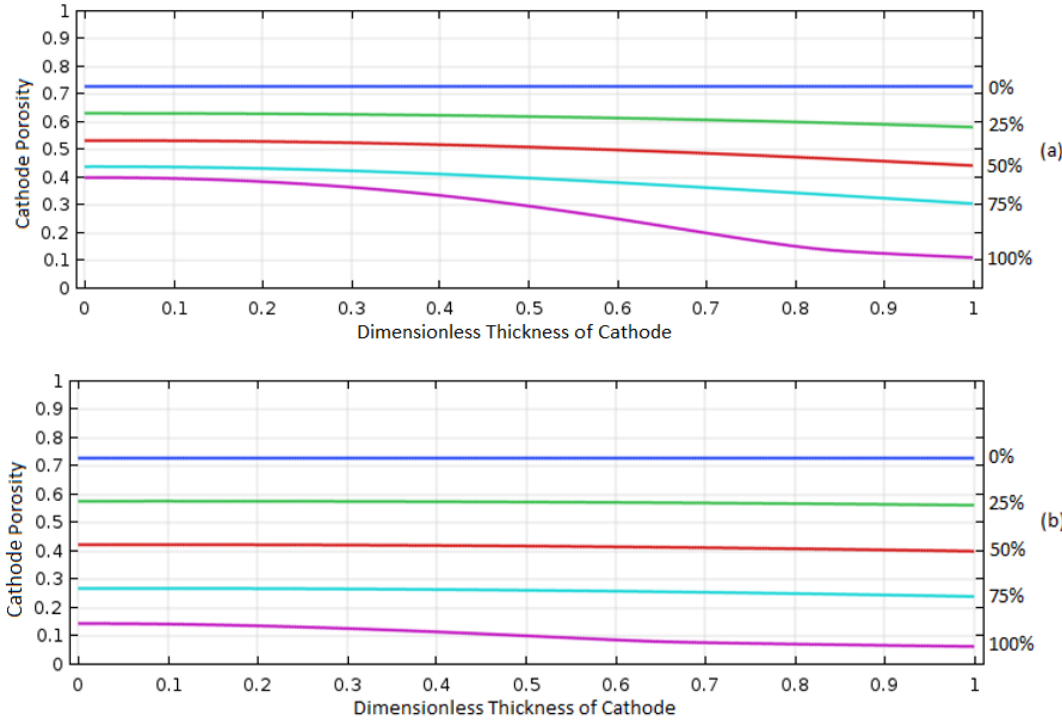
Figure 8. Distribution of cathode porosity from 0% to 100% discharge at 1 A / m 2 current density for O 2 solubilities of ( a ) 0.2 and ( b ) 0.8 in the electrolyte, with a cathode electrode of which thickness and porosity are 195 µ m and 0.73, respectively.